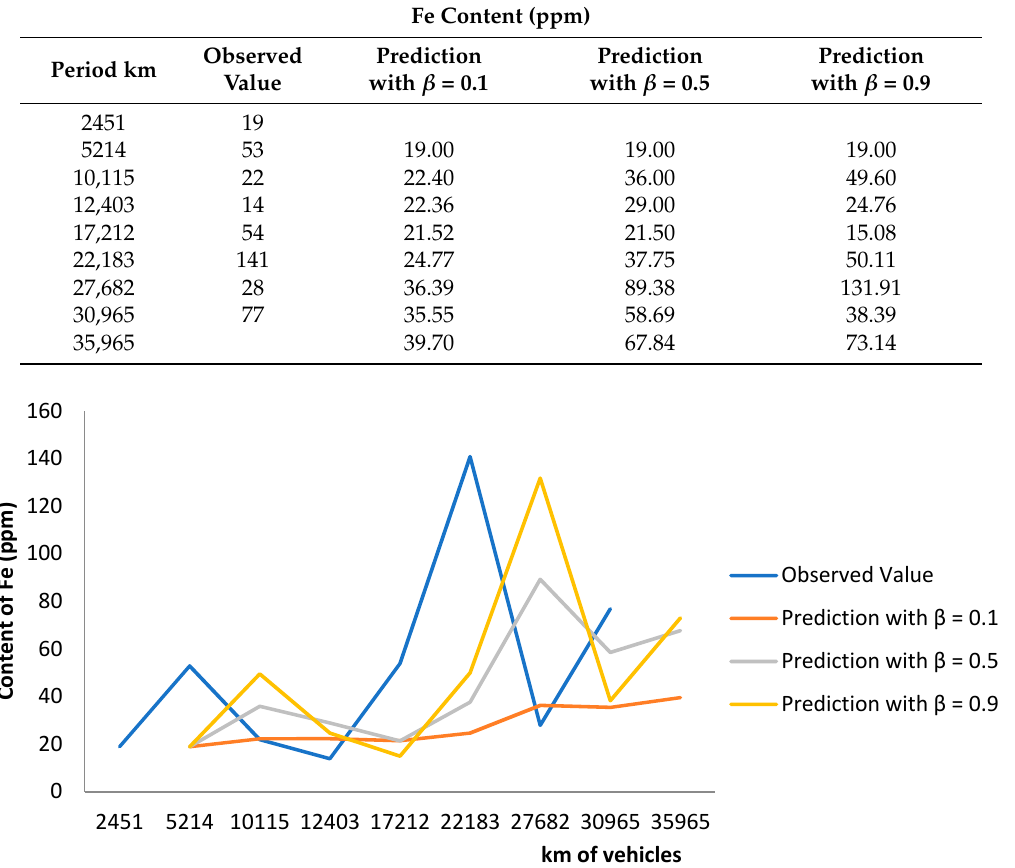
Table 2. Application of exponential smoothing-Fe (ppm) content.